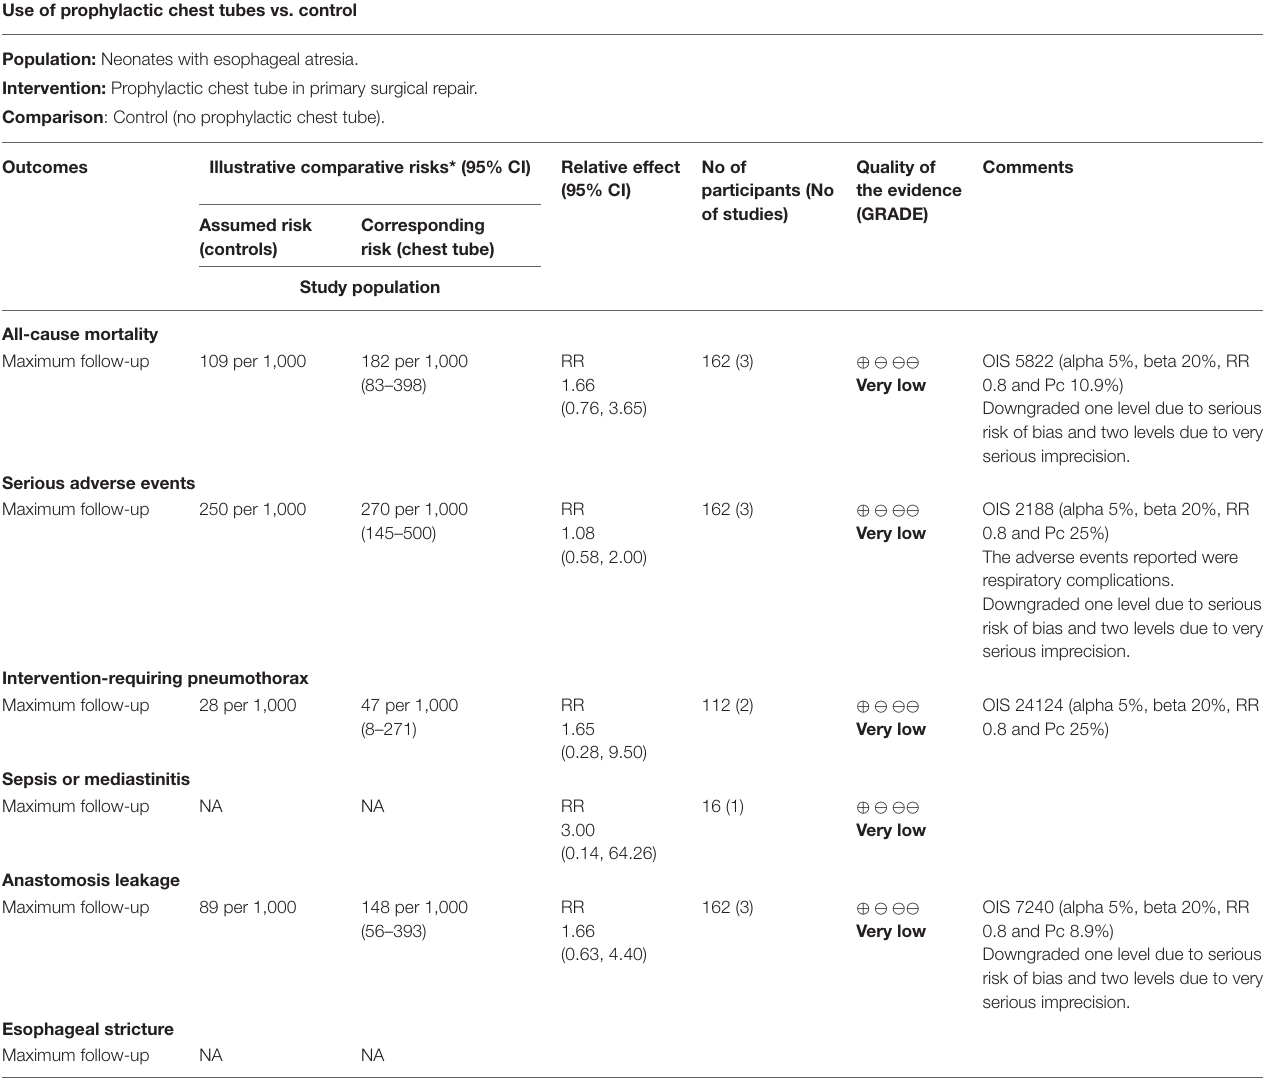
TABLE 2 | Summary of findings, randomized clinical trials. Use of prophylactic chest tubes vs.